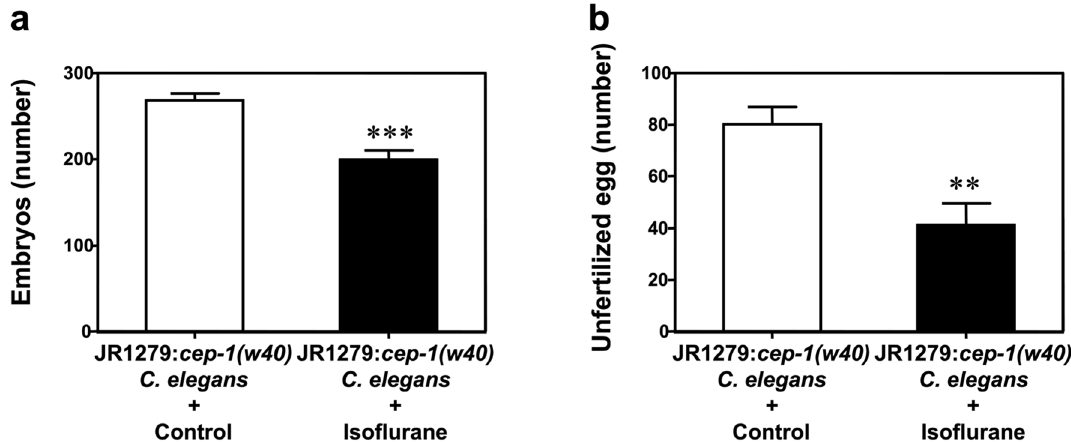
Figure 2. Isoflurane impaired oogenesis in cep-1 knockout C. elegans . ( a ) Treatment with 7% isoflurane for 4 h decreased the number of embryos of cep-1 knockout hermaphrodites. ( b ) Treatment with 7% isoflurane for 4 h decreased the number of unfertilized eggs of cep-1 knockout hermaphrodites. All data are presented as mean ± S.D. N = 10 hermaphrodites in each group. JR1279: C. elegans strain cep-1(w40) . The Student’s t-test was used to analyze the data presented in ( a , b ); the P values refer to the difference between the control condition and isoflurane. ** P < 0.01, *** P < 0.001.